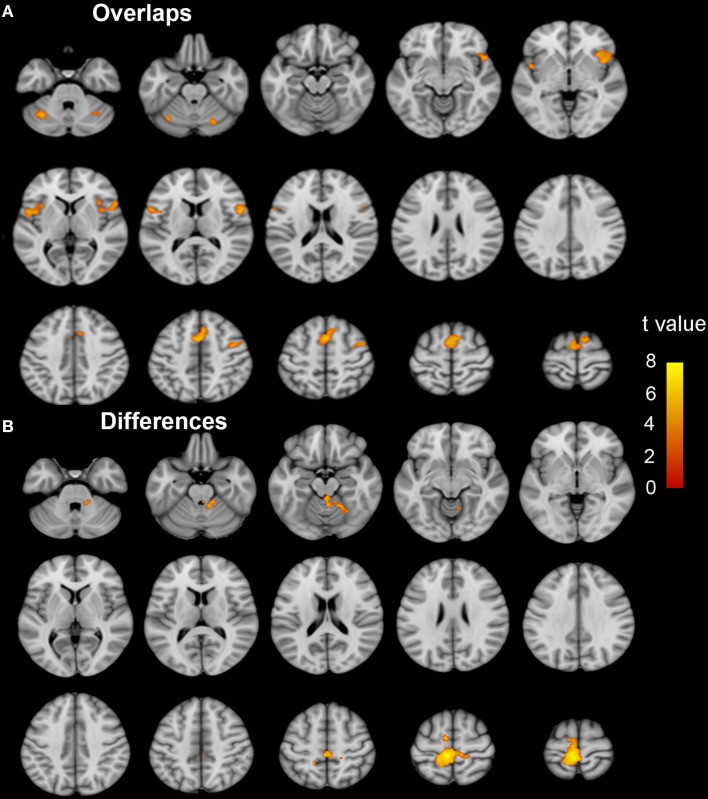
The coactivation and differences between the MI and ME tasks in ISCI patients. The coactivation pattern of the MI and ME tasks was similar but weaker than that of the NC group (A). Compared to the ME task, the MI task evoked weaker activation in the bilateral SMA, CB lube 6, IFO, aINS, left CB Crus 1, MFG, left paracentral lobule, precuneus, right CB vermal 4–5 and lobules 4–6 (B). Significant activation was considered at a voxel-wise threshold of q < 0.01 (FDR correction) and cluster ≥30 voxels. The right side of the image corresponds to the right hemisphere. The color bar represents the t-values. MI, motor imagery; ME, motor execution; ISCI, incomplete spinal cord injury; NC, normal controls; SMA, supplementary motor area; CB, cerebellum; IFO, inferior frontal operculum; aINS, anterior insula; MFG, middle frontal gyrus.